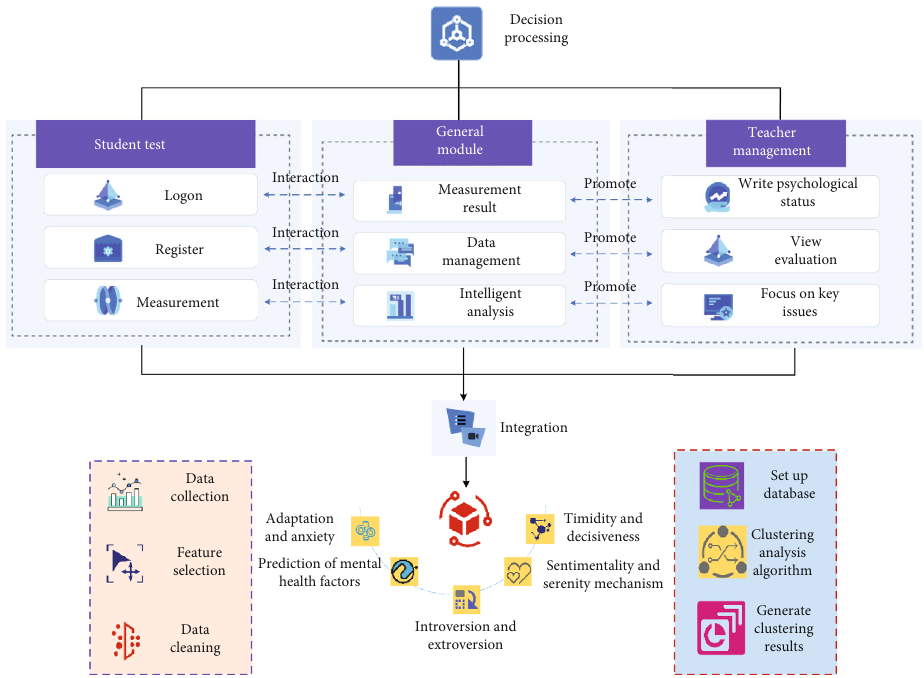
Figure 2: Steps and processes of physical training and occupational